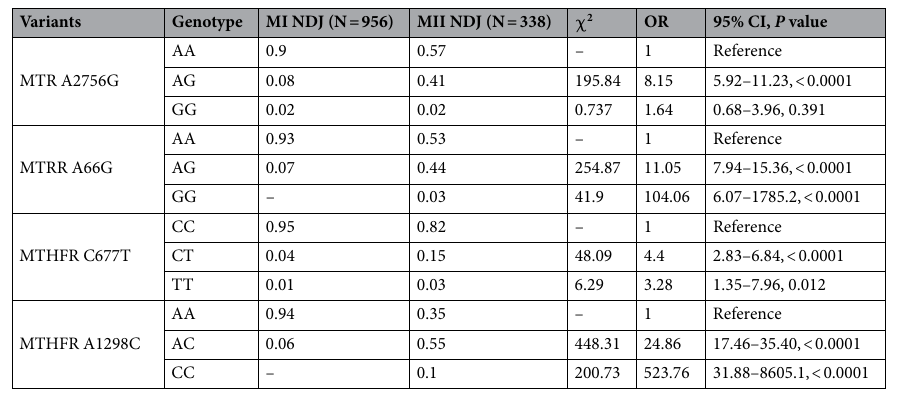
Table 2. Genotype frequency of folate regulator mutants MTR A2756G, MTRR A66G, MTHFR C677T and MTHFR A1298C among the DS bearing women stratified by meiotic errors. Chi square ( χ 2 ) test was performed to compare MI: MII ratios; Odds ratios with respective 95% Confidence Interval (CI) were calculated to find out the association of genotypes with meiotic outcome groups and two-tailed P value < 0.016 is considered statistically significant after Bonferroni correction test.The genotype data of MI group used as reference. MI Meiosis I, MII Meiosis II, NDJ nondisjunction, N number of individuals, χ 2 chi square, OR odd ratio, CI confidence